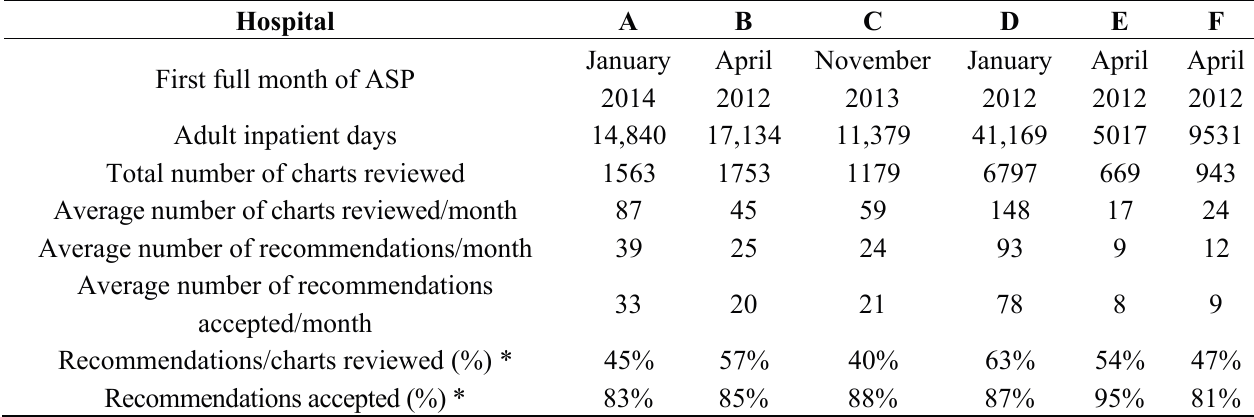
Table 3. Monthly antimicrobial stewardship program (ASP) activity (first full month of ASP through June 2015).